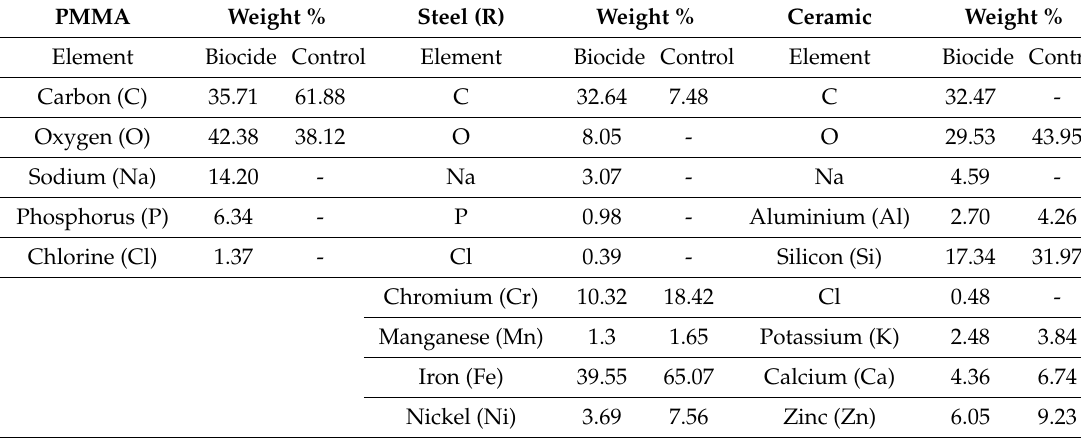
Table 1. EDX results for “Biocide” and “Control” surfaces, reporting the relative weight % of surface composition. Steel (R) denotes rough steel